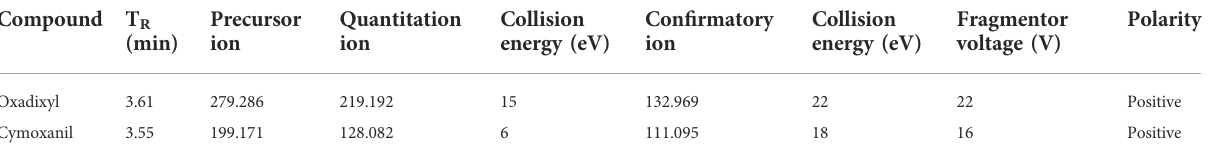
TABLE 3 LC-MS/MS (ESI) characteristics of oxadixyl and